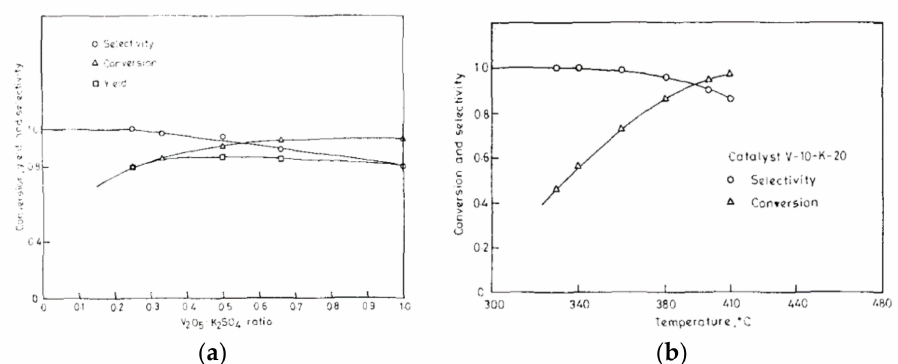
Figure 28. ( a ) Effect of catalyst composition on conversion, yield, and selectivity: W/F = 42.0 g · h/mol, T = 410 ◦ C, and 10 vol.% MeOH in air. ( b ) Effect of temperature on conversion and selectivity for W/F = 41g · h/mol and 10 vol.% MeOH in air. Reprinted from [178] Copyright © (1978), with permission from